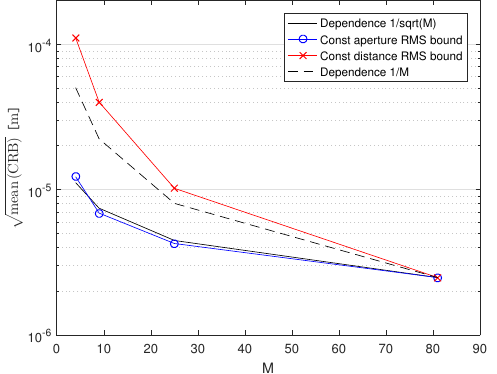
Figure 7. Dependence of the CRB on the number of antennas, M